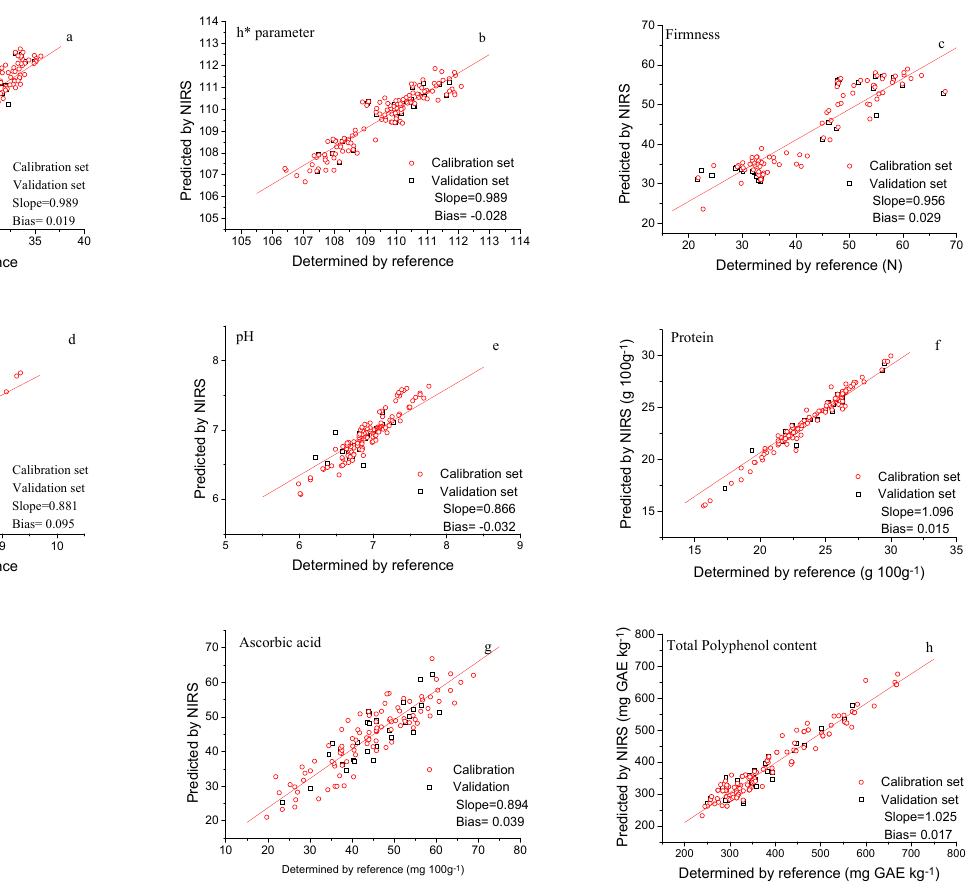
Figure 7. Predicted versus reference values for calibration and external validation for all parameters: c* ( a ); h* ( b ); firmness ( c ); total soluble solids ( d ); pH ( e ); protein content ( f ); ascorbic acid ( g ); total polyphenol content in the mangetout ( h ).